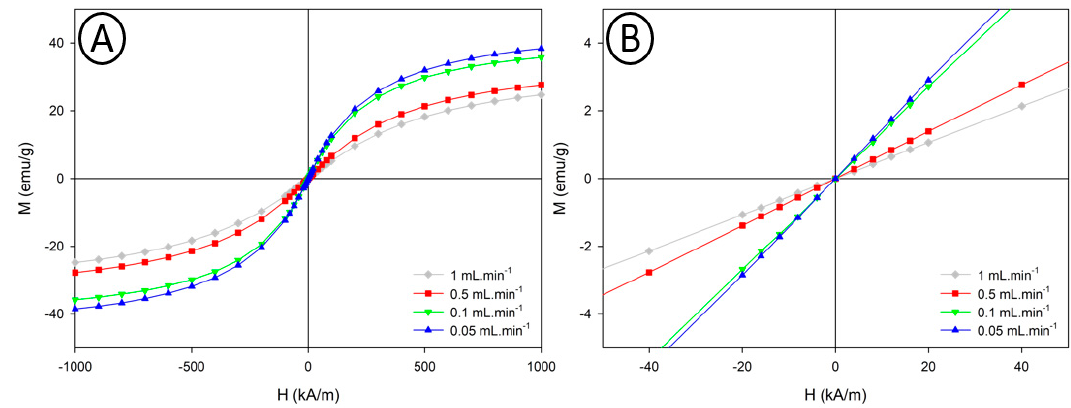
Figure 9. Magnetization curves of samples obtained in the 1 mm capillary reactor as a function of the applied magnetic field ( A ); Zoomed region around origin ( B ).